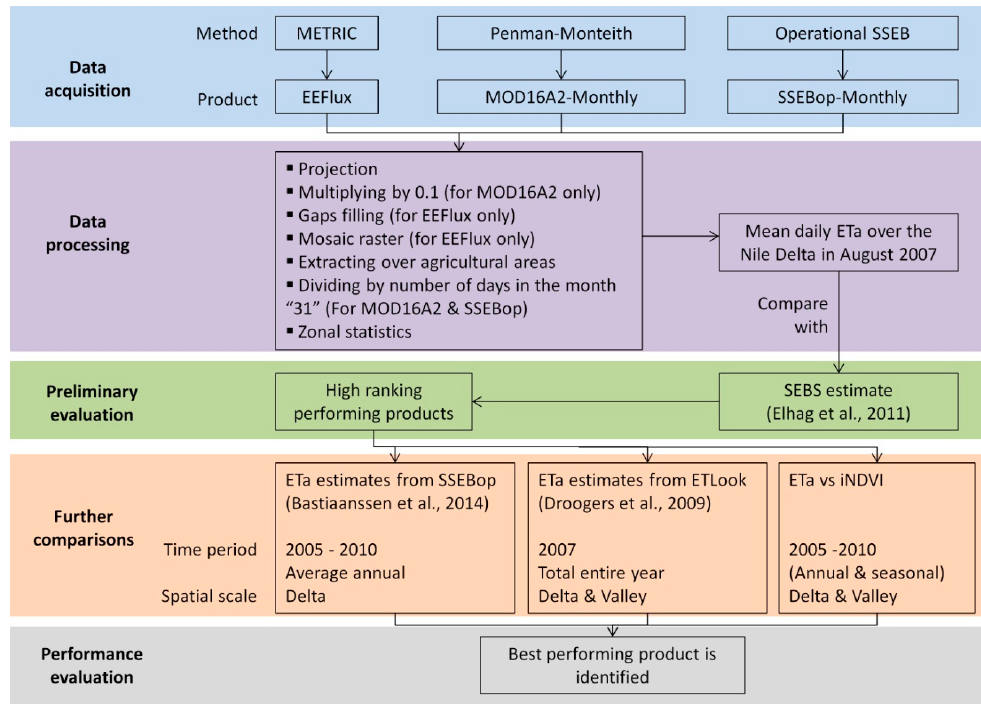
Figure 2. Evaluation process of three selected ETa product.